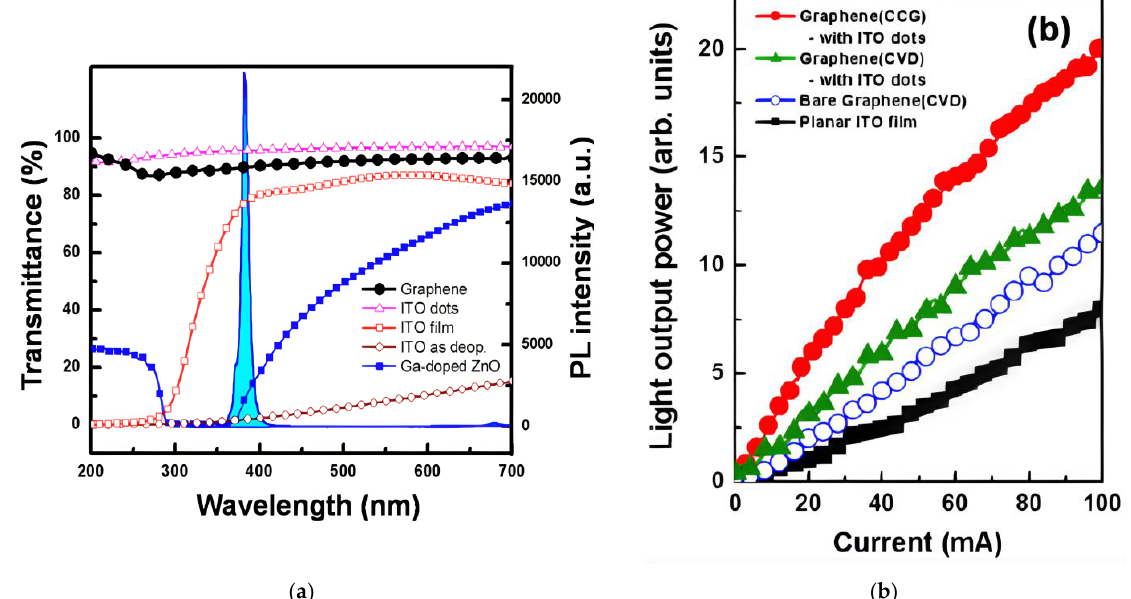
Figure 3. Graphene networked with ITO nanodots as TCSL integrated into GaN-based MQW LEDs: ( a ) the transmittance of a CCG graphene film (black full circles) compared to: ITO nanodots (pink triangles), annealed ITO film (red open squares), as-deposited ITO film (brown open circles), and Ga-doped ZnO (blue full squares); ( b ) the light output power in a typical LED device with four TCSLs: 250 nm thick ITO film (black squares), transferred CVD grown graphene (blue open circles), transferred CVD grown graphene networked with ITO nanodots (green triangles) and CCG graphene with ITO nanodots (red full circles). Reproduced with permission from [50]. Copyright 2011 Optical Society of